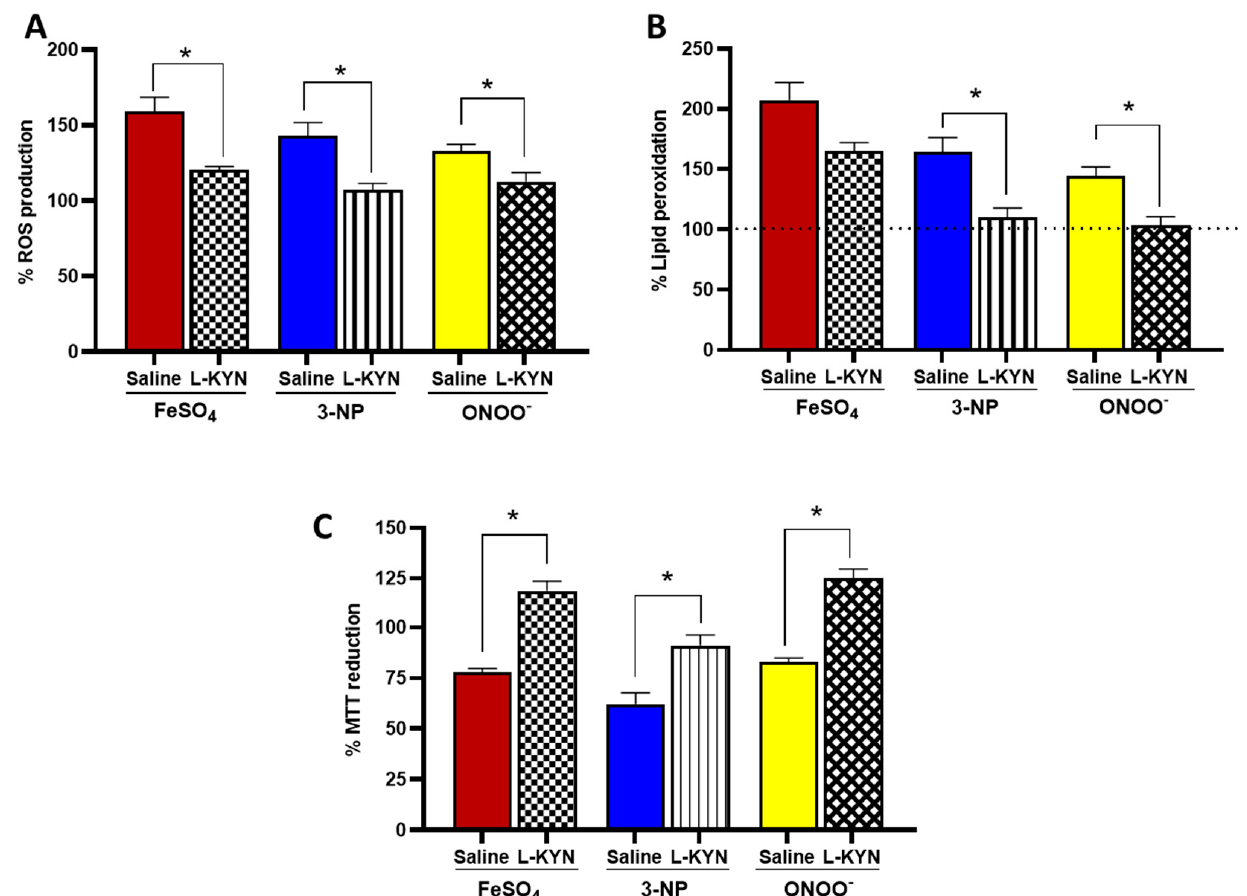
Figure 8. Effect of L-KYN treatment on ( A ) ROS, ( B ) LP and ( C ) MTT reduction in rat brain homogenates after the ex vivo exposure to pro-oxidants. After the last L-KYN administration, brain homogenates were incubated in the presence of FeSO 4 , 3-NP and ONOO − , then oxidative markers were determined considering the control as 100%. Data are the mean ± SEM ( n = 5 per group); * p < 0.05 L-KYN vs. Saline based on the Mann–Whitney test for each pro-oxidant.